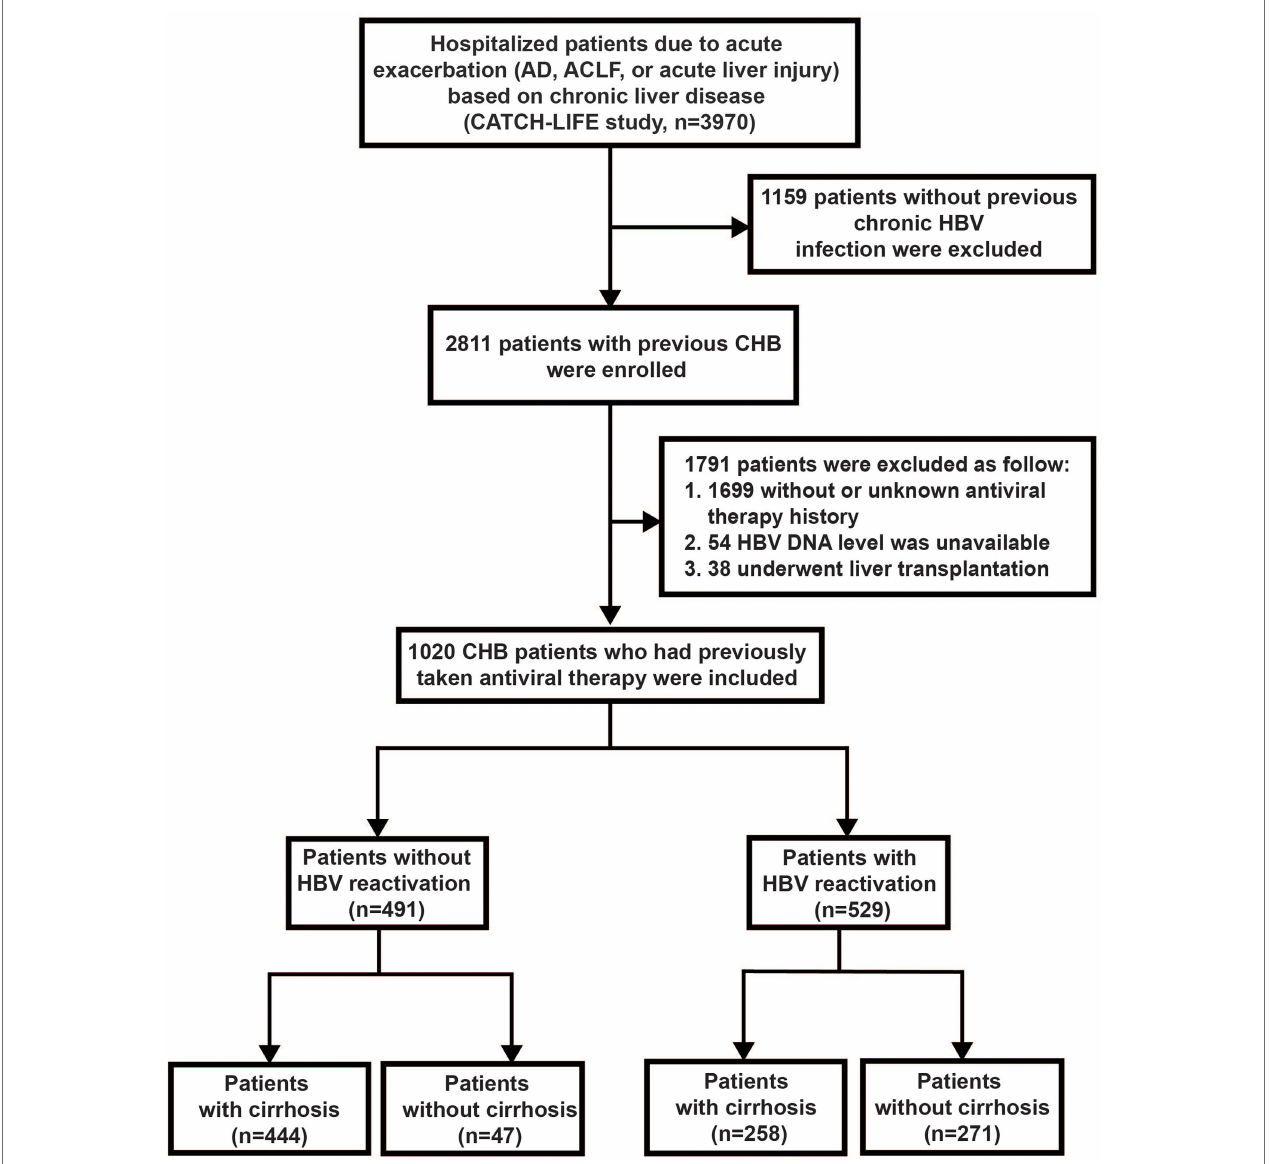
FIGURE 1 | Screening, enrollment, and flow of patients. AD, acute decompensation; ACLF, acute-on-chronic liver failure; and CHB, chronic hepatitis